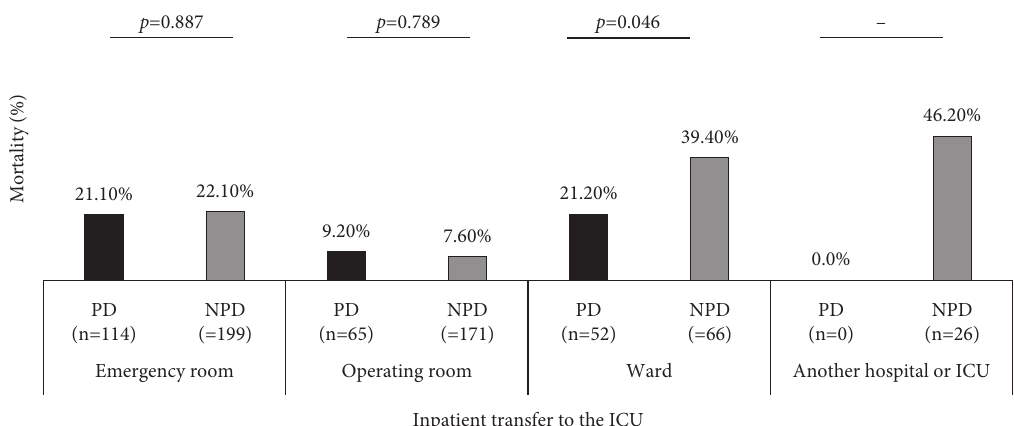
Figure 4: Comparison of mortality rates between patients with and without Parkinson’s disease (PD and NPD, respectively) according to the source of transfer to the intensive care unit (ICU). The comparison was not performed in the group “another hospital or ICU,” since no patients in the PD group were transferred from another ICU or hospital. The results are presented in percentage of deaths considering the total number of patients admitted according to the source of transfer to the ICU stratified by the PD/NPD group. The p values > 0.012 refer the significance adjusted of the chi-square test result.